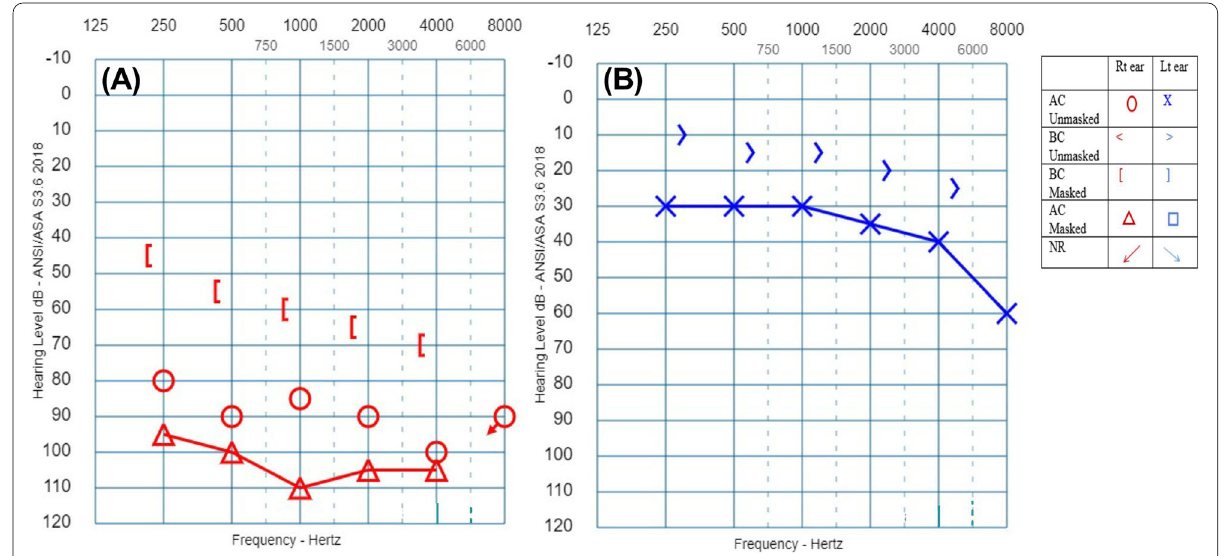
Fig. 1 Auditory thresholds corresponding to the right ear ( A ) and left ear ( B ) in the test of pure tone